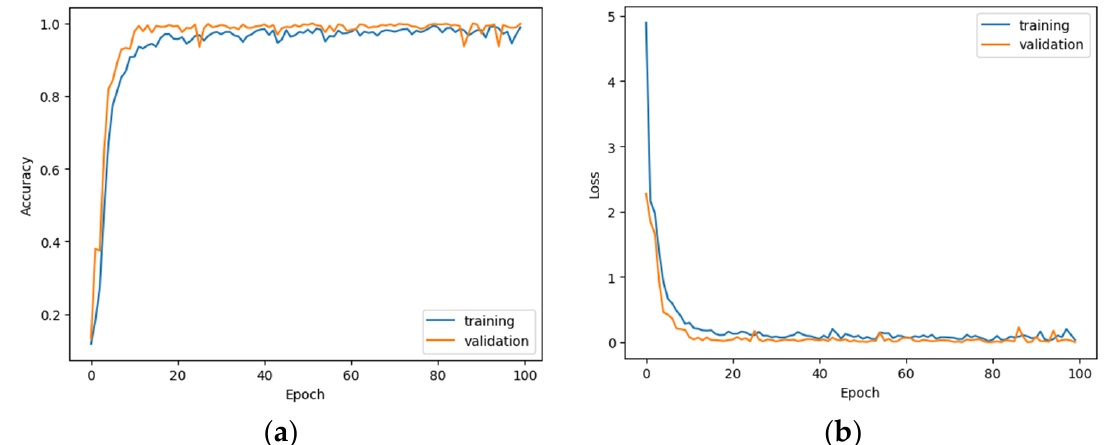
Sensors 2023 , 23 , x FOR PEER REVIEW 16 of 22